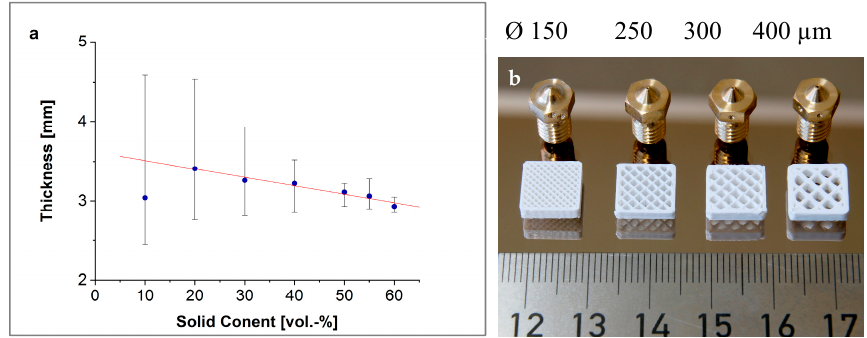
Figure 6. ( a ) Filament diameter as function of solid content, and ( b ) open test structures printed with different nozzle sizes.